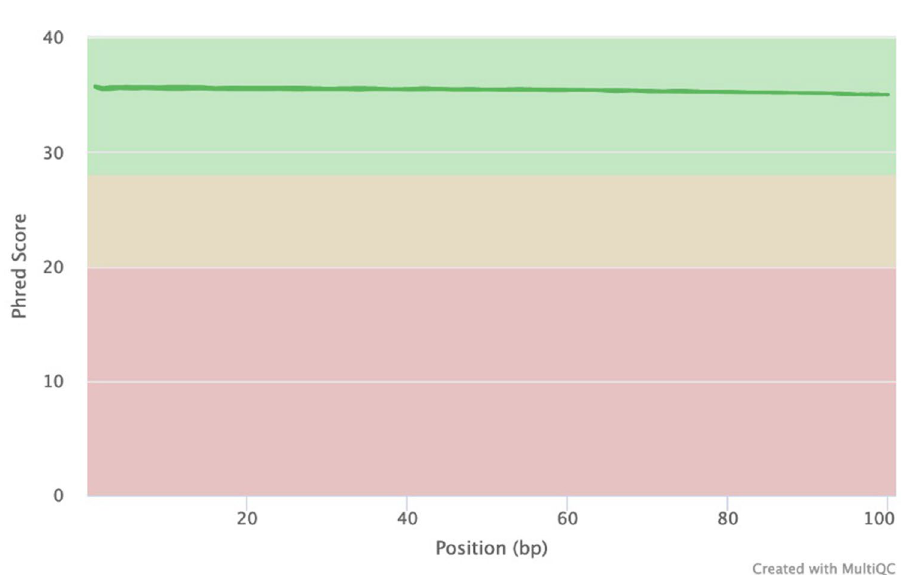
Figure 6. FastQC mean quality scores for Sample A . FastQC quality scores for Sample A were obtained. The quality scores are representative of those obtained from both the MGISEQ-2000 in South Africa and the BGISEQ-500 in